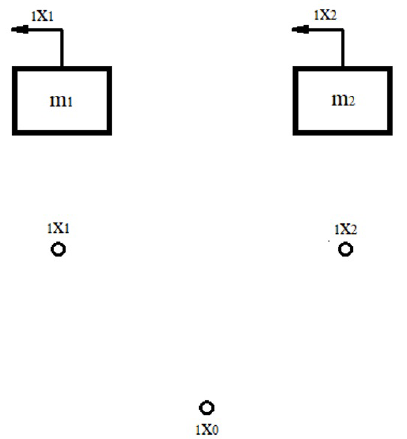
Figure 7. Additional graph edges representing spring loads.